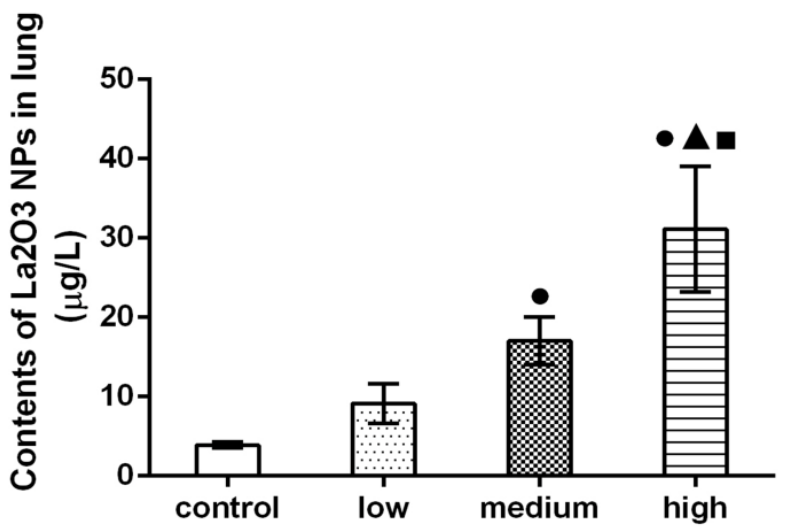
Figure 4. Contents of La 2 O 3 NPs in lung of rats. Note: ● , compared with the control group, p < 0.05; ▲ , compared with the low group, p < 0.05; ■ , compared with the medium group, p < 0.05.